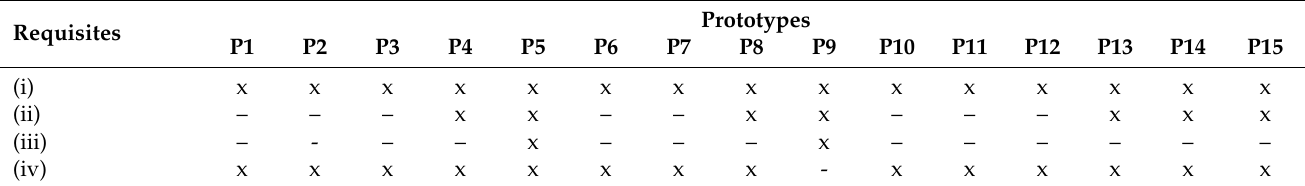
Table 7. Requisites that accomplish each prototype (“x” indicates prototype accomplish the requisite and “–” does not accomplish).